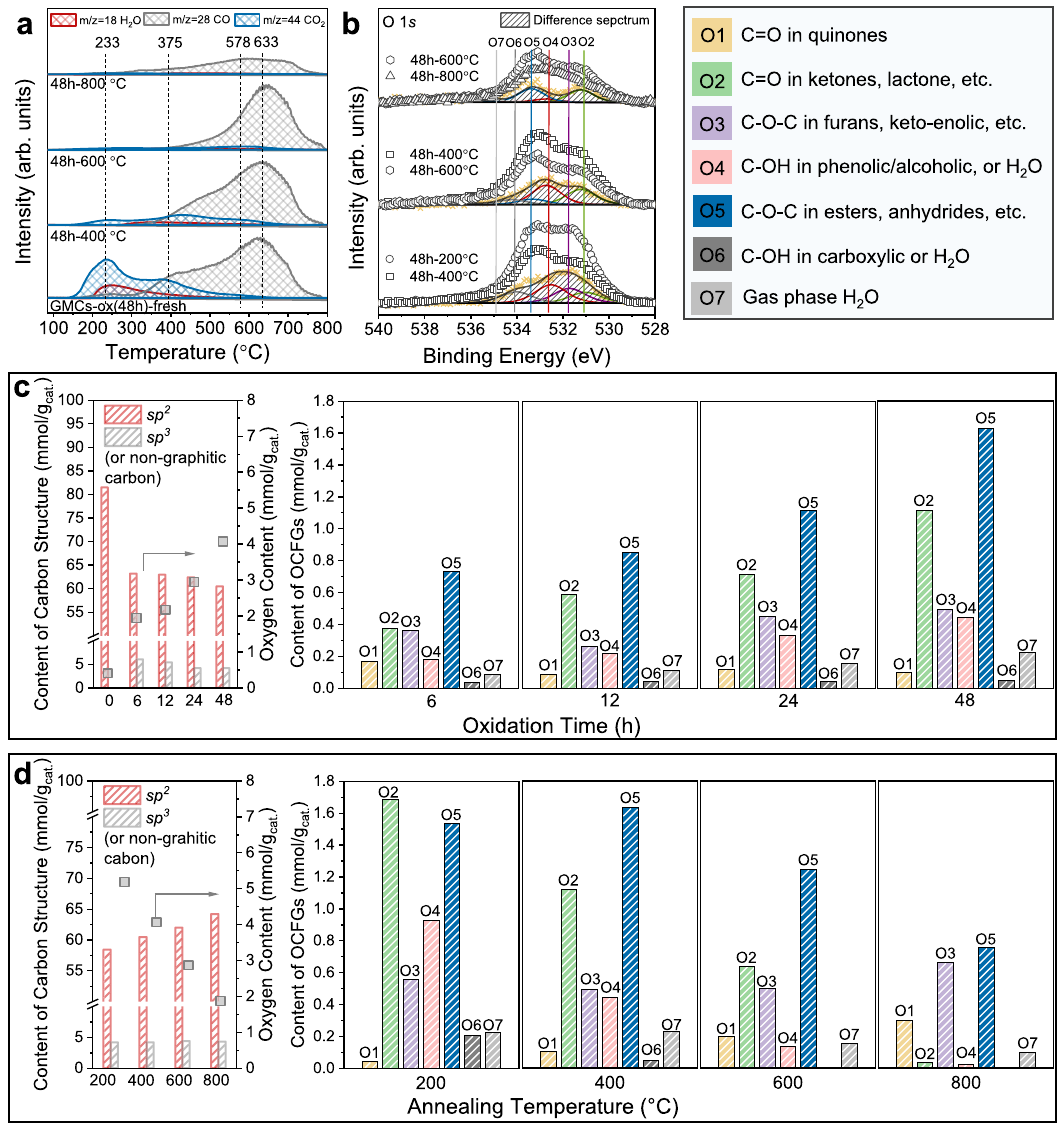
Fig. 2 | Carbon hybridization and OCFGs at various conditions. a TPDE-MS pro fi les of CO, CO 2 , and H 2 O for GMCs-ox (48h)-fresh, GMCs-ox (48h)-b °C, (b=400, 600, and 800°C). b O 1 s ranges of XPS spectra and difference spectra